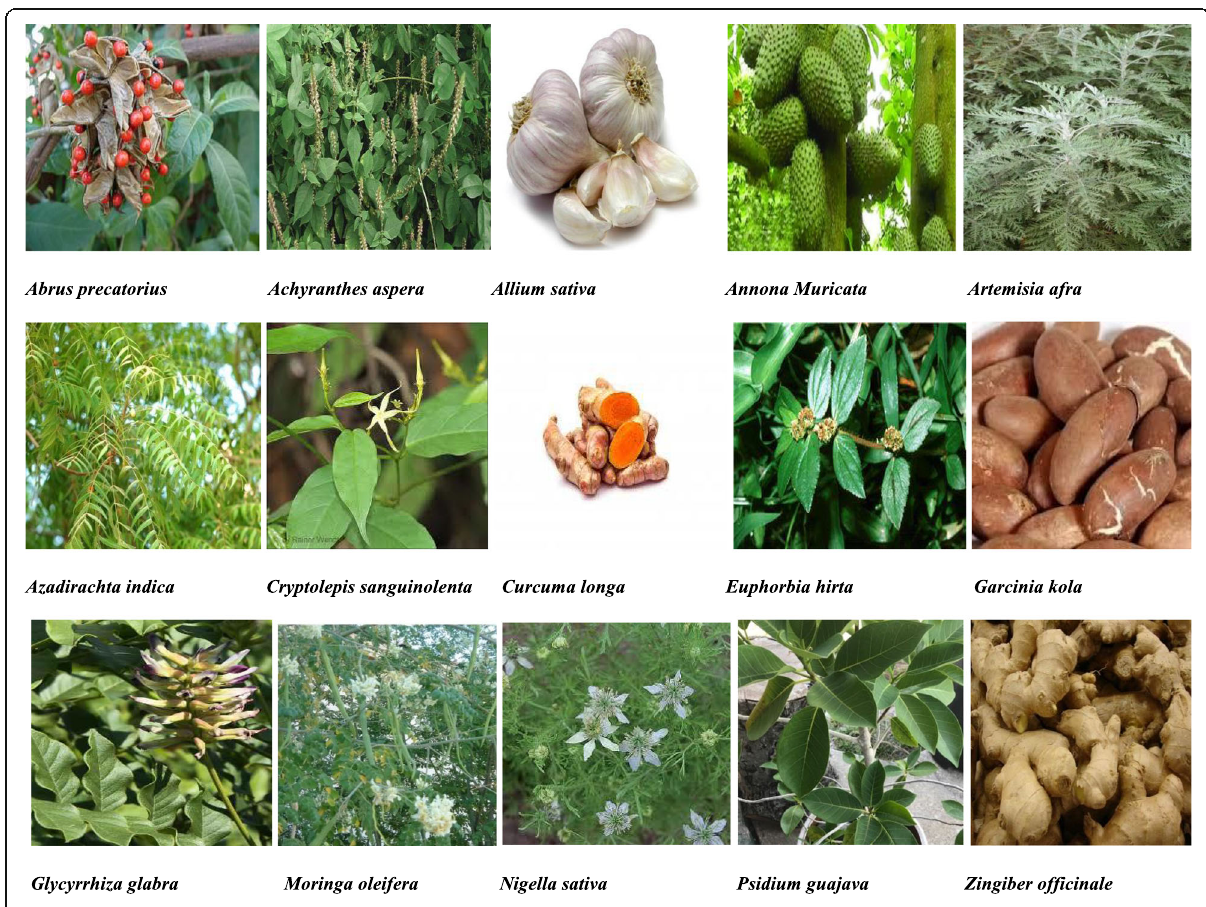
Fig. 1 Photos of ethnomedicinal herbs with potential activity for the management of coronavirus disease